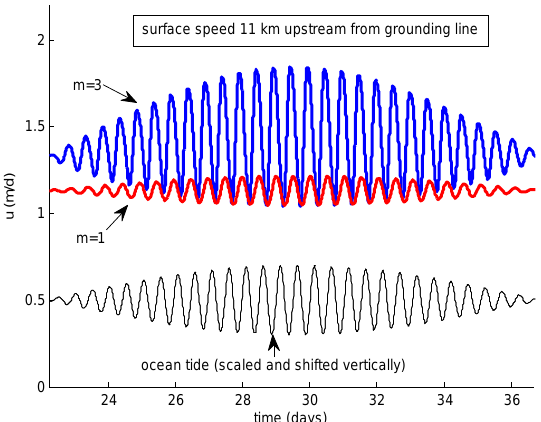
Fig. 7. Surface velocity 11km upstream from the grounding line for m = 1 (red curve) and m = 3 (blue curve). The ocean tidal ampli- tude is shown for comparison (black curve) and is scaled by a factor of 20 and shifted for display purposes. Model geometry, rheologi- cal parameter values, and oceanic forcing are all identical to those used in Fig. 4 and are described in